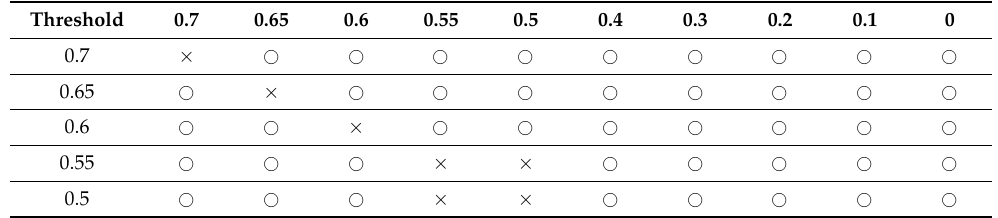
Figure 4. Distribution of KGE in the validation period of MME by the model with a threshold of 0. The darker the red, the higher the KGE and the more robust the basin. Blue basins are basins that do not have complete data for either the calibration period or the validation period. Table 1. The result when MME is taken based on the different threshold of KGE. Also, it shows the differences for KGE in the calibration